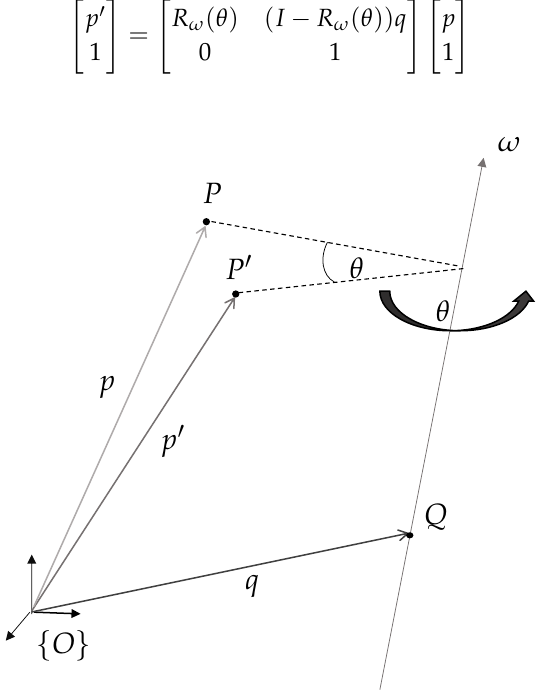
Figure 3. Rotation of a point p by an angle θ around a single axis ω